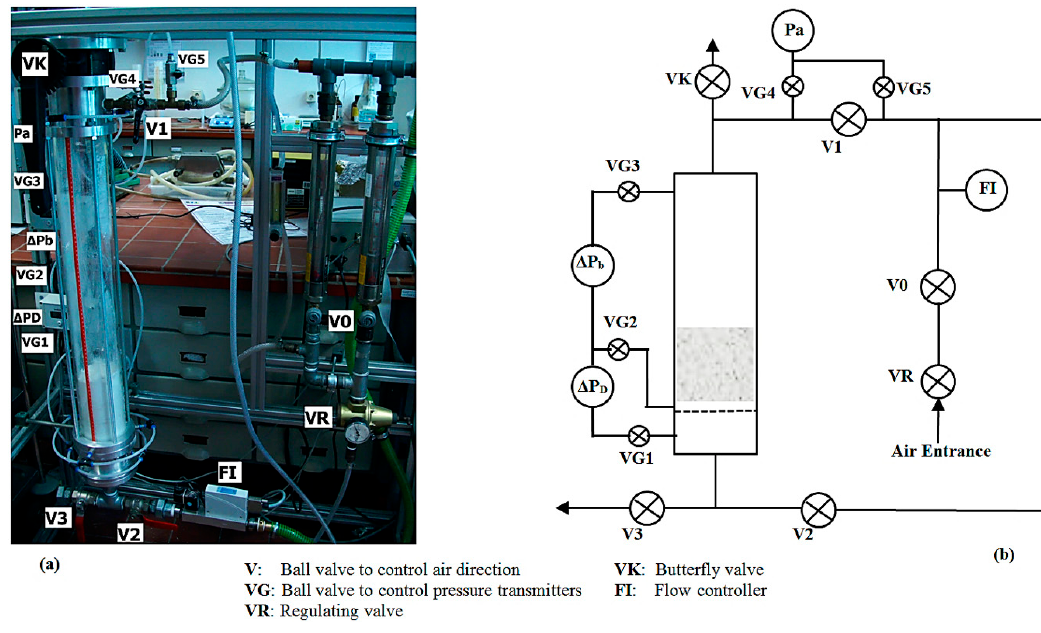
Figure 3. ( a ) Snapshot and ( b ) scheme of the test rig.